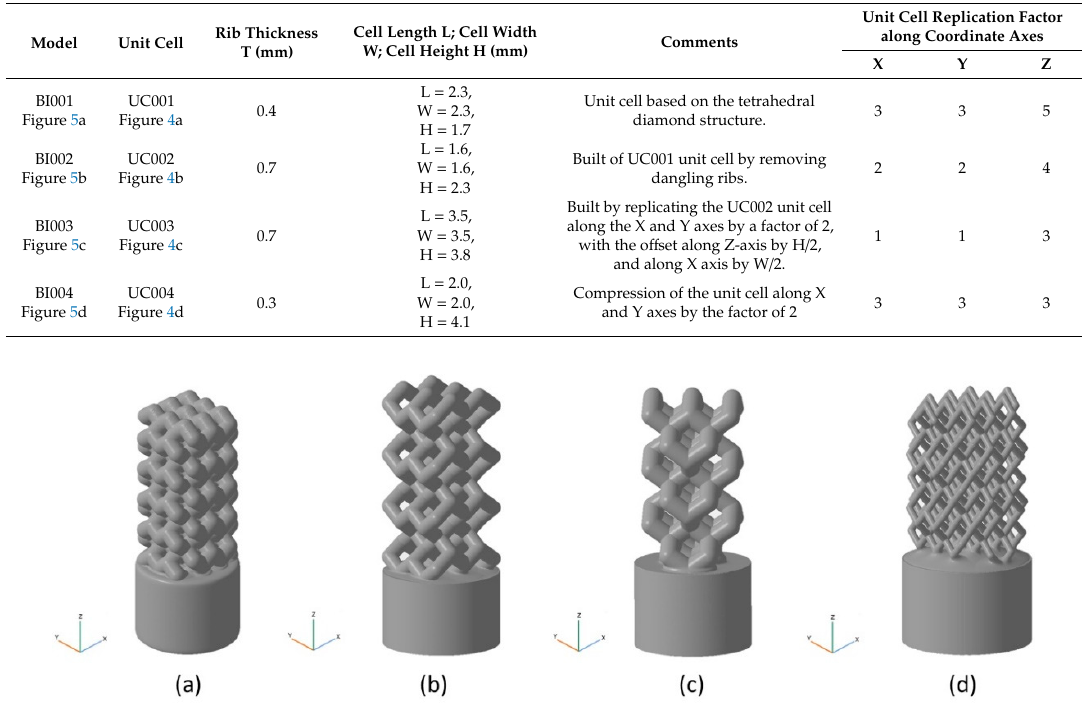
Figure 5. The models of implants. Combination of a wireframe with a cylindrical base plate: ( a ) BI001—the wireframe built by replicating the UC001 unit cell along three coordinate axes, by a factor of 3 along X and Y axes, and by a factor of 5 along Z-axis; ( b ) BI002—the UC002 unit cell is replicated by a factor of 2 along X and Y axes, and by the factor of 4 along Z axis; ( c ) BI003—the UC003 unit cell is replicated by a factor of 1 along X and Y axes, and by a factor of 3 along Z-axis; ( d ) BI004—the UC004 unit cell is replicated by a factor of 3 along X,Y, and Z axes.